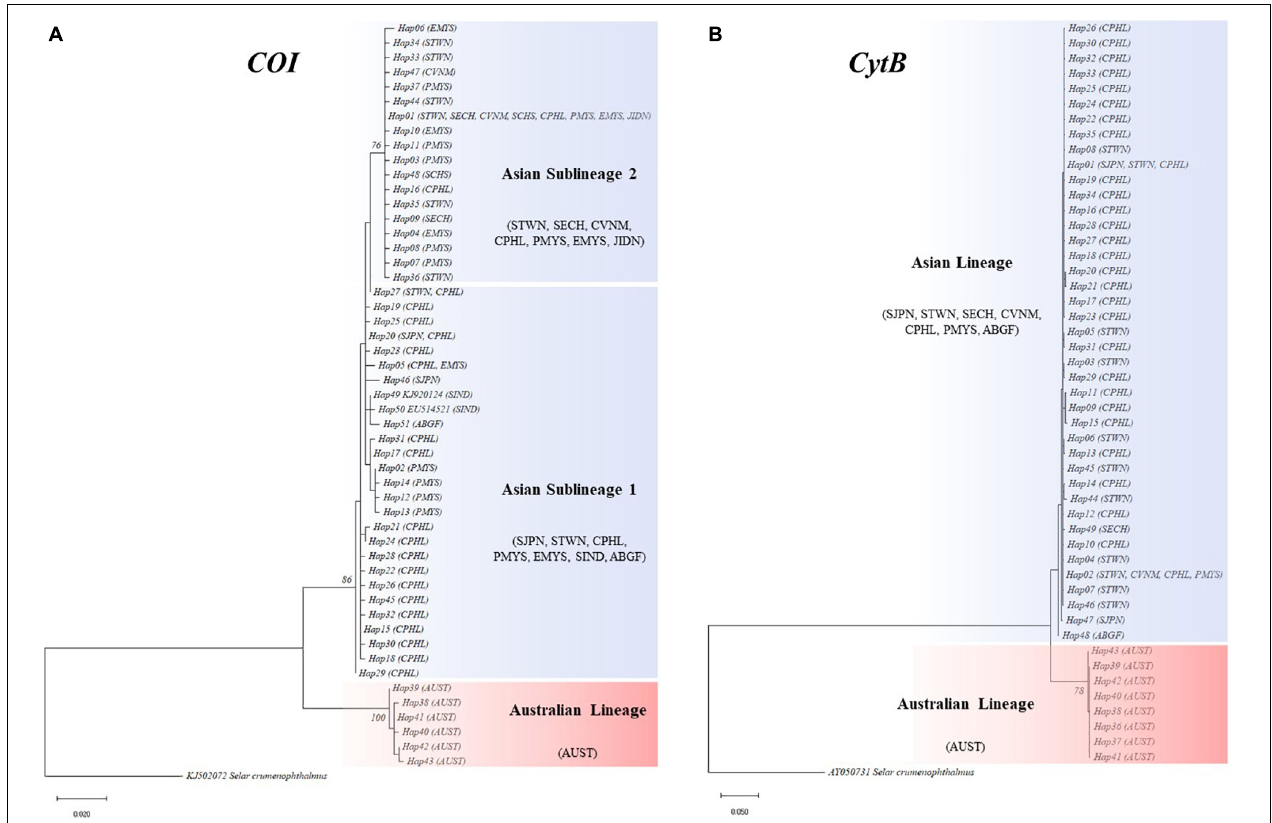
FIGURE 3 | (A) Cytochrome oxidase I (COI) and (B) cytochrome B (CytB) maximum likelihood (ML) trees of S. leptolepis rooted with S. crumenophthalmus (KJ502072, AY050731) from GenBank. Bootstrap consensus tree for the topology was inferred from 1,000 replicates and > 75% support labels are retained at tree